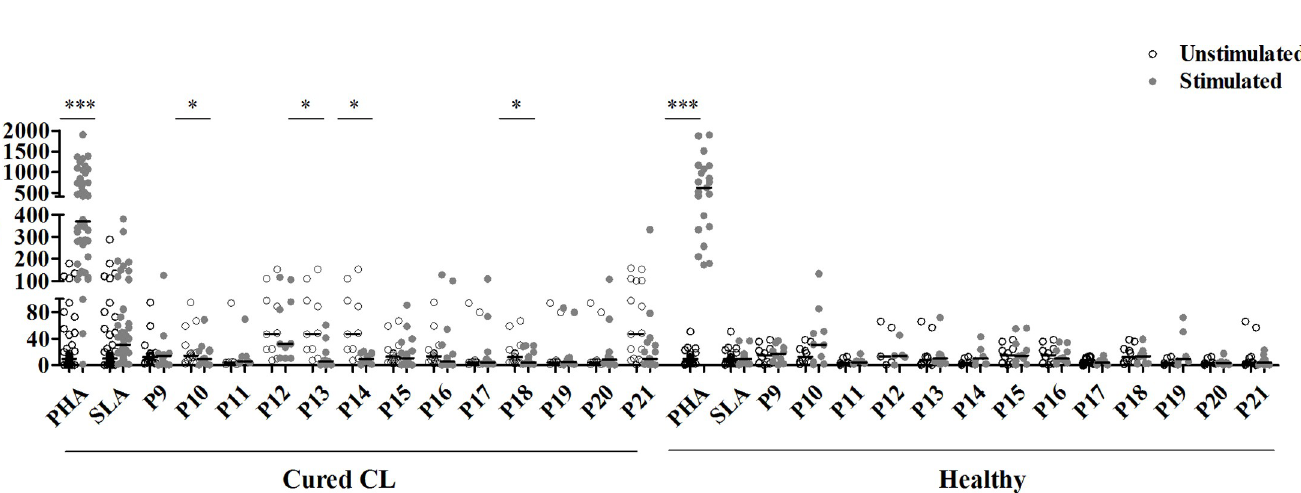
Fig 4. IL-10 responses to multi-epitope peptides used individually or as pools composed of HLA-I or HLA-II peptides. IL-10 was quantified by ELISA, in culture supernatants of PBMC from cured CL subjects (N = 16) or healthy individuals (N = 10) stimulated with multi-epitope peptides (1 μ M) used individually (A) , or as peptide pools composed of HLA-I (B) or HLA-II (C) peptides, for 10 days. PHA and SLA were used as positive controls (10 μ g/ml). Horizontal bars represent median values. Statistical significance was assigned to a value of p < 0,05 ( � p < 0.05, �� p < 0.01, ��� p < 0.001).